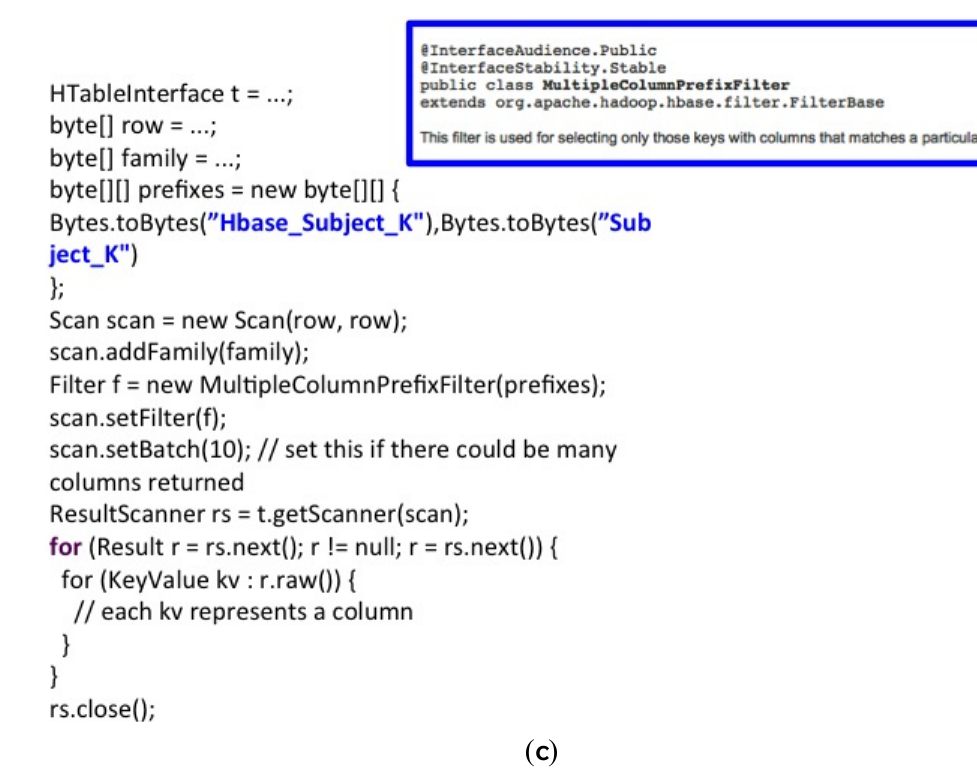
Figure 7. ( a ) HBase built on top of HDFS; ( b ) Java Client API of Subject K